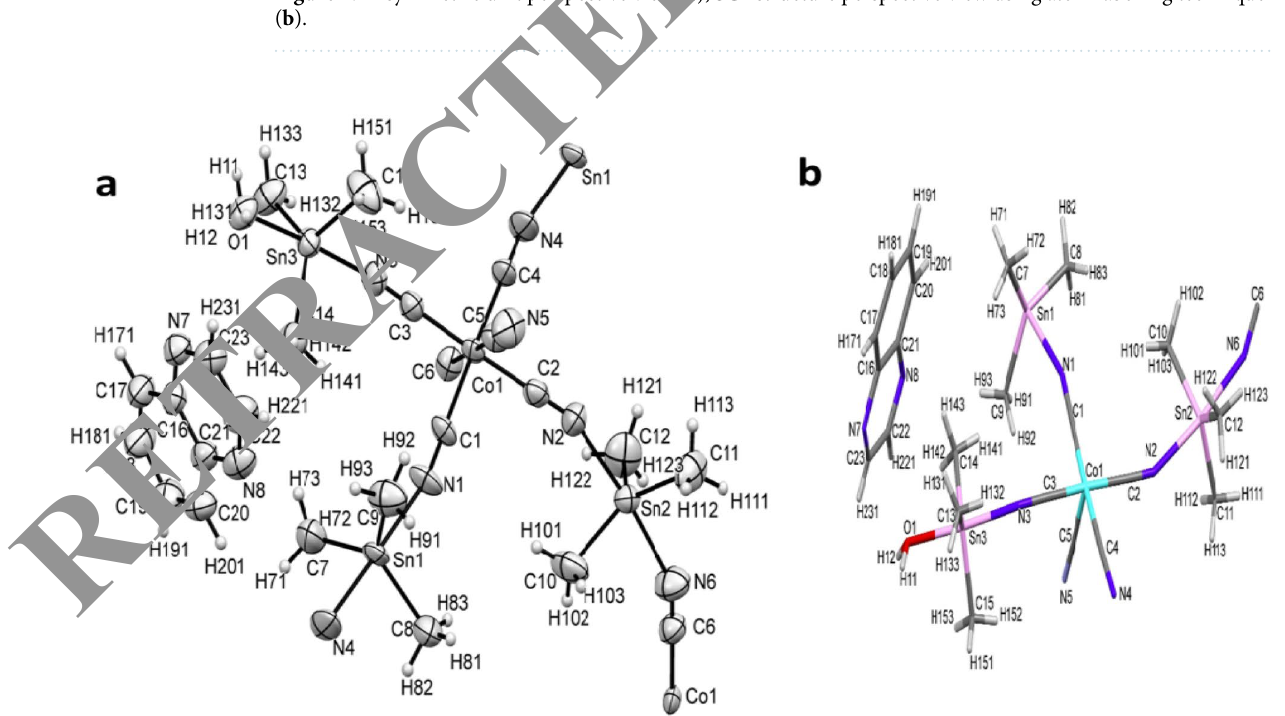
Figure 1. Asymmetric unit perspective view ( a ); SC1 structure perspective view using atom labelling technique ( b ).